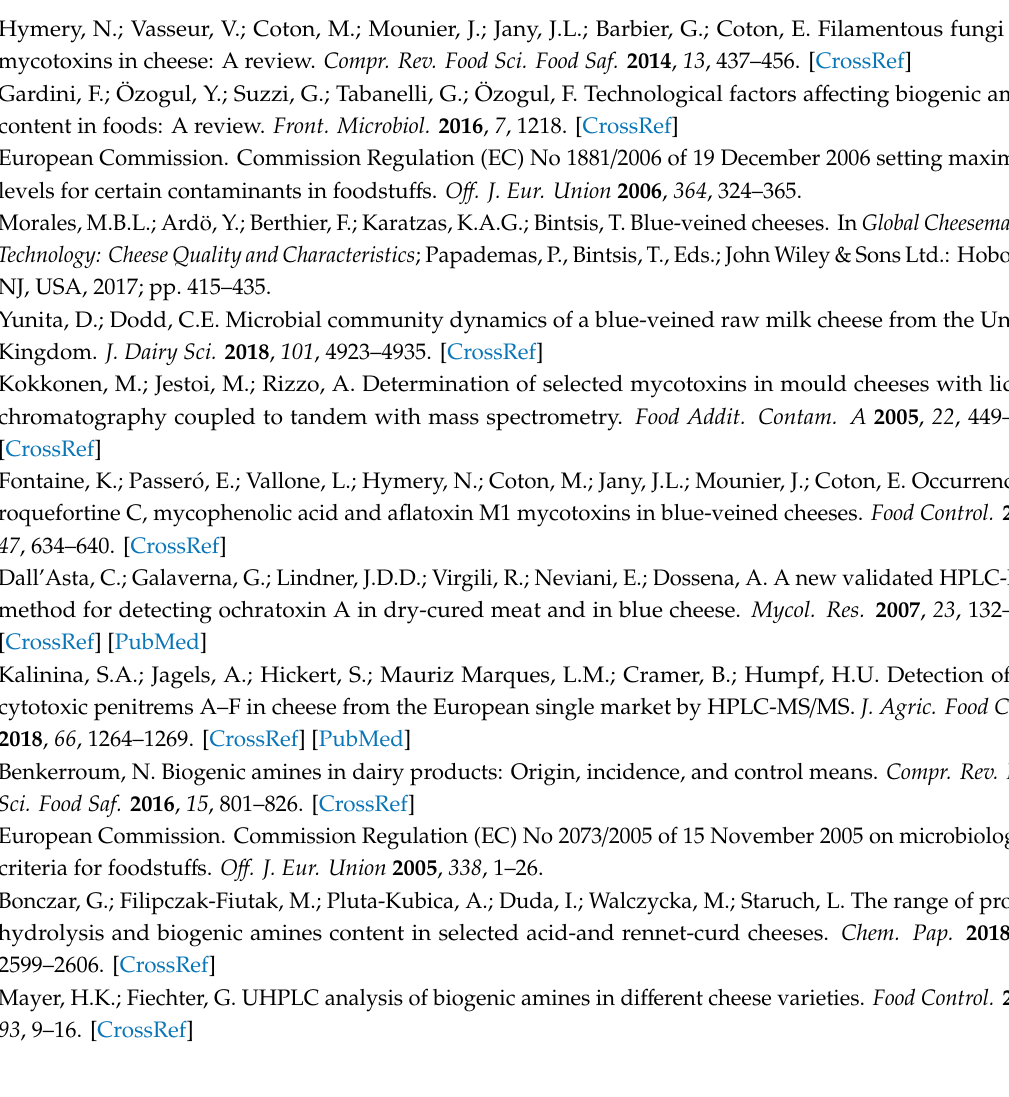
values (g × kg − 1 bw × day − 1 ) for di ff erent age groups of the population across di ff erent countries (data from the EFSA database), Table S6: Chronic dietary exposure (g × kg − 1 bw × day − 1 ) to heavy metals via blue cheese; (A) Native chronic consumption data, (B) Dietary exposure levels for average consumers, (C) Dietary exposure for high consumers, Table S7: Acute dietary exposure in (g × kg − 1 bw × day − 1 ) to biogenic amines via blue cheese; (A) Native acute consumption data, (B) Dietary exposure levels for average consumers, (C) Dietary exposure for high consumers, (D) Dietary exposure for high consumers, using 95th percentile occurrence data, Table S8: Acute dietary exposure levels (g × kg − 1 bw × day − 1 ) to mycotoxins from blue cheese; (A) Native acute